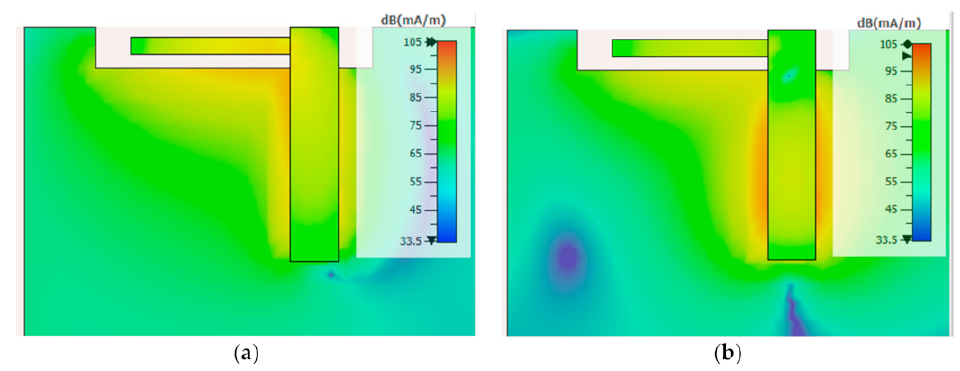
Figure 2. Surface Current Patterns. ( a ) 3.5 GHz ( b ) 5.5 GHz.